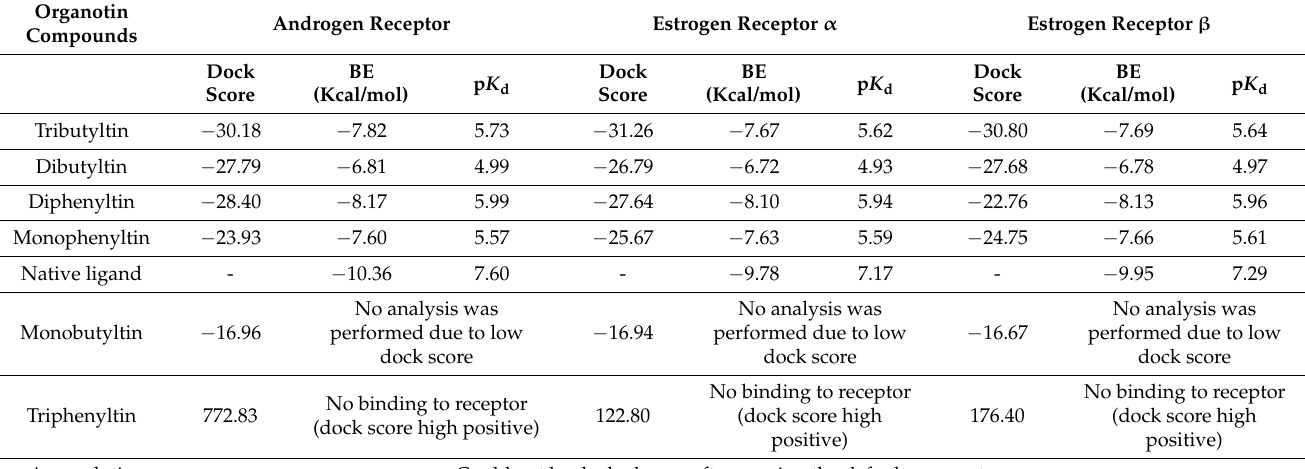
Table 1. The binding strength scores, i.e., dock score, binding energy (BE), and dissociation constant (p K d ) for organotin compounds with androgen receptor, estrogen receptor α , and estrogen receptor β . The BE and p K d values were calculated using X-Score. Lower (more negative) BE or dock score and higher p K d denote better docking. Monobutyltin showed a weak binding (low dock score), and further analysis was not performed for its any other parameters. Triphenyltin did not bind to any of the receptors (high positive dock score), and azocyclotin could not be docked even after varying the default